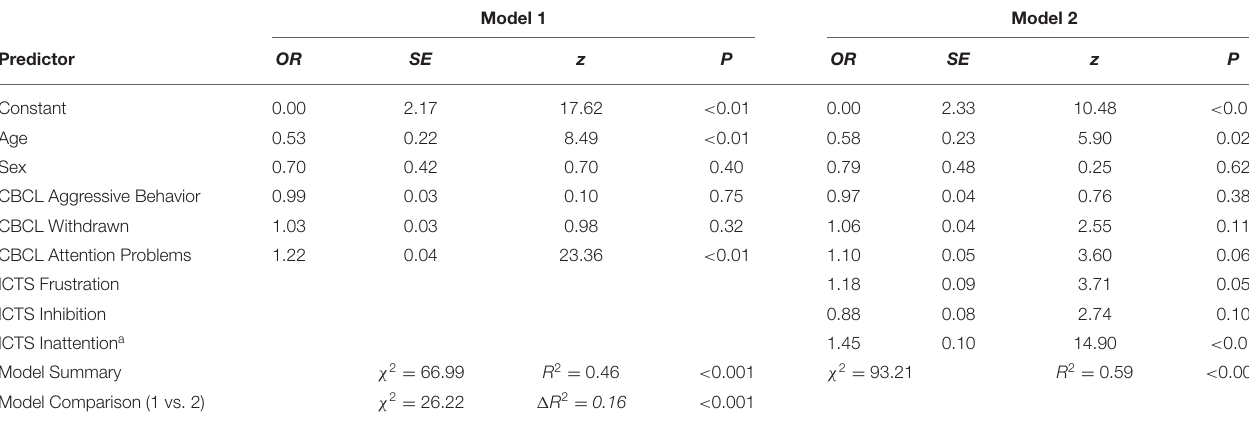
TABLE 8 | Summary of a multivariate binary logistic regression analysis predicting clinical treatment from ICTS and specific CBCL